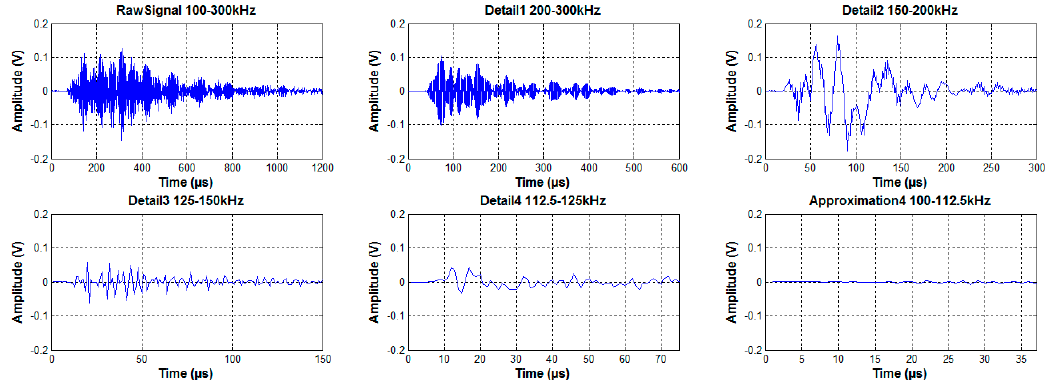
Figure 3. Example wavelet decomposition of an acousto-ultrasonic (AU) signal using 4 decomposition levels. The raw signal and the four wavelet detail signals as well as the residuals (approximation) are presented.